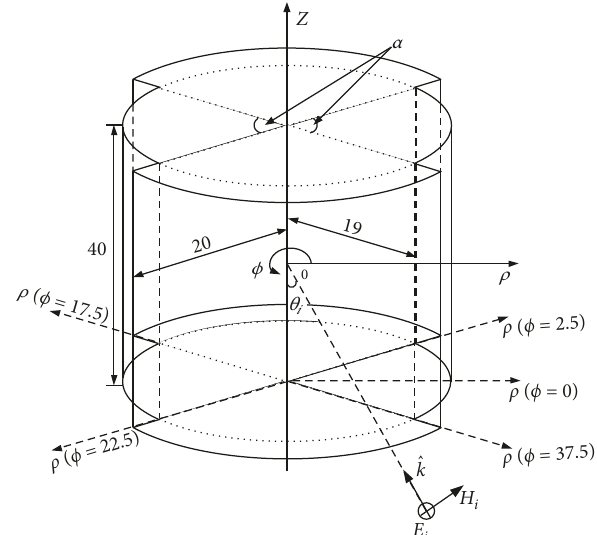
Figure 4: Illustration of the irregular cylinder with two grooves under the oblique incident wave.